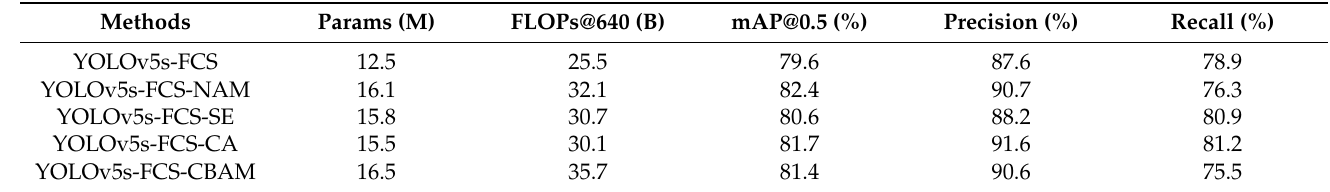
Table 4. Comparative experiments of different attention mechanisms on VOC 2007 datasets.